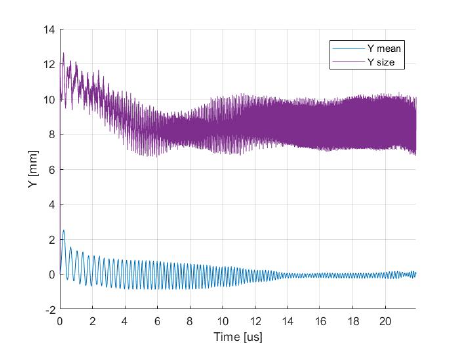
Figure 11. Beam transverse envelope for the standard operation